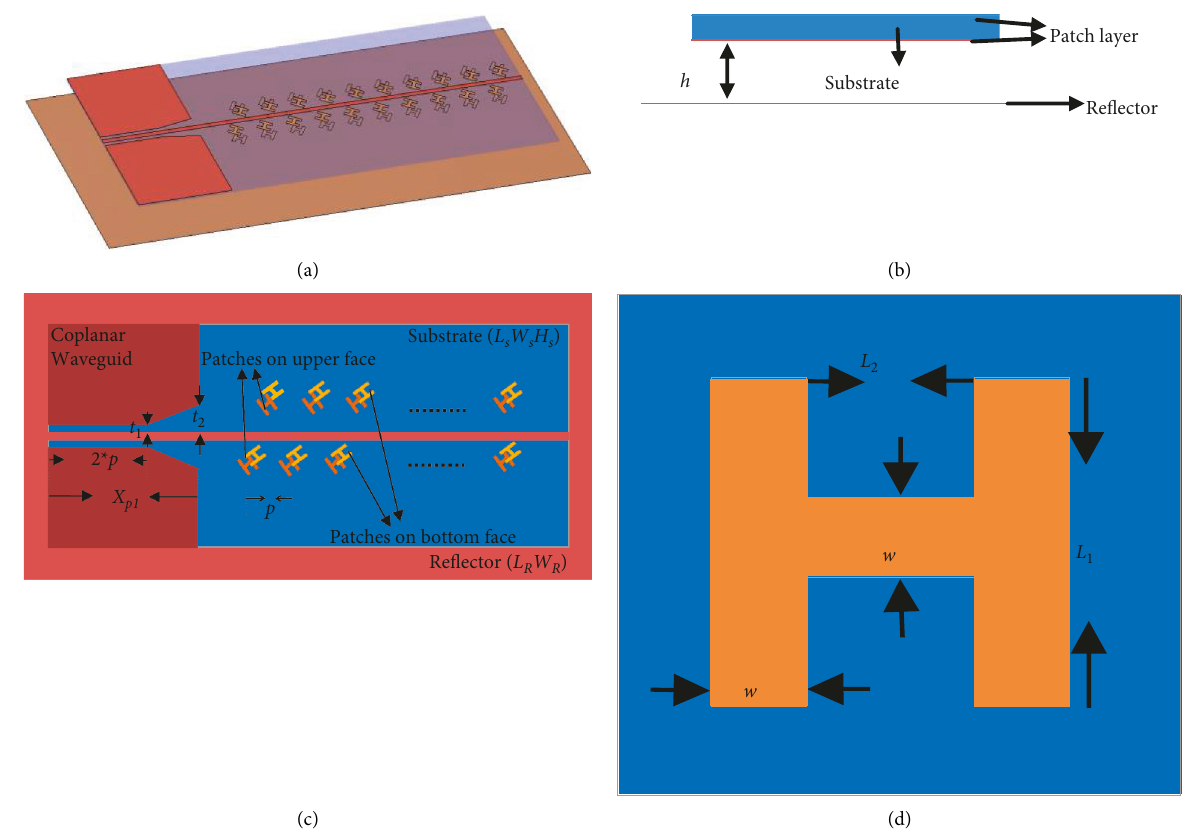
Figure 1: Parameters and configuration of the CP antenna. (a) 3D view. (b) Side view. (c) Top view. (d) H -shaped patch.